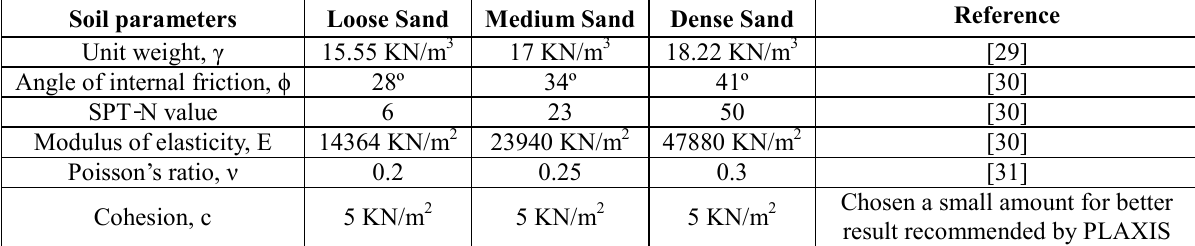
Bearing capacity calculation of D